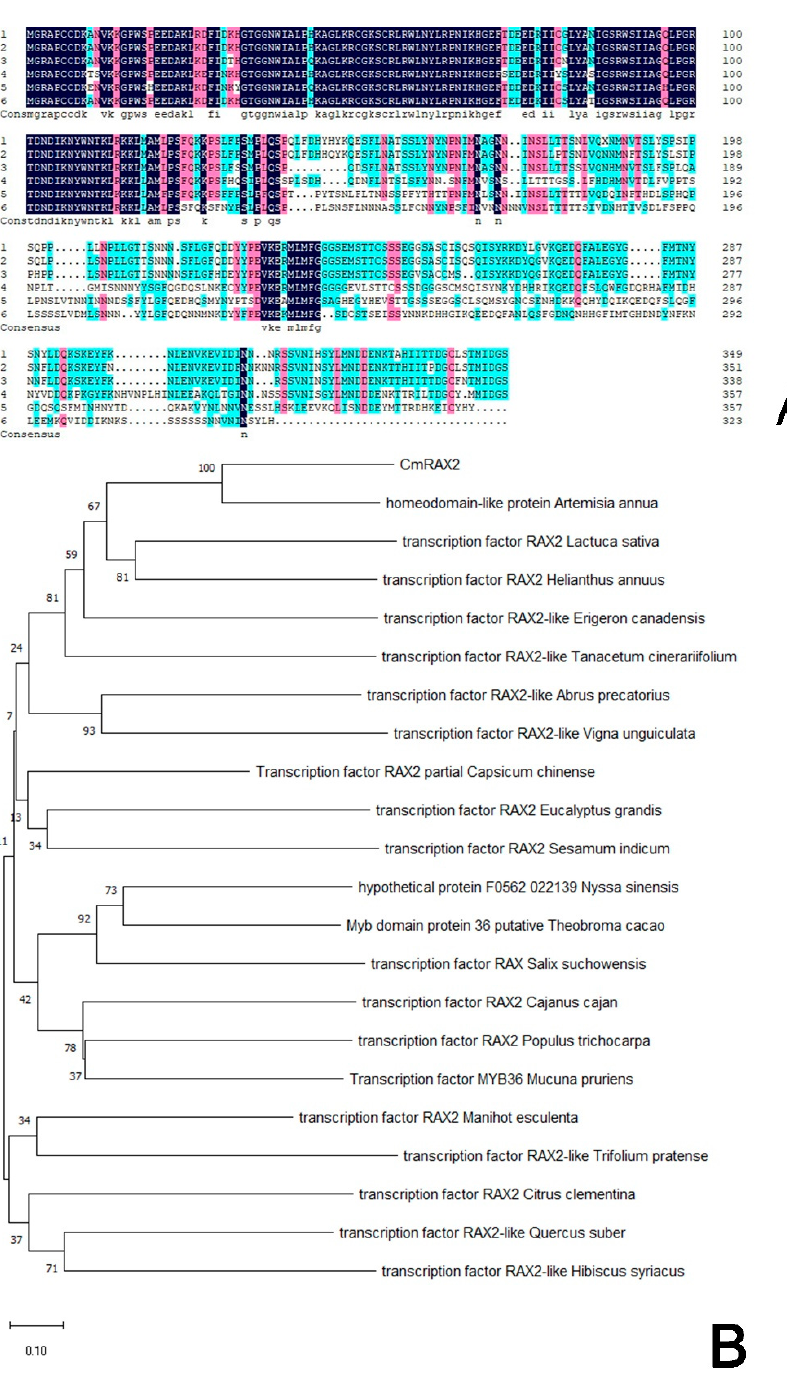
CmRAX2 protein with the RAX2 protein sequence in other species was compared using